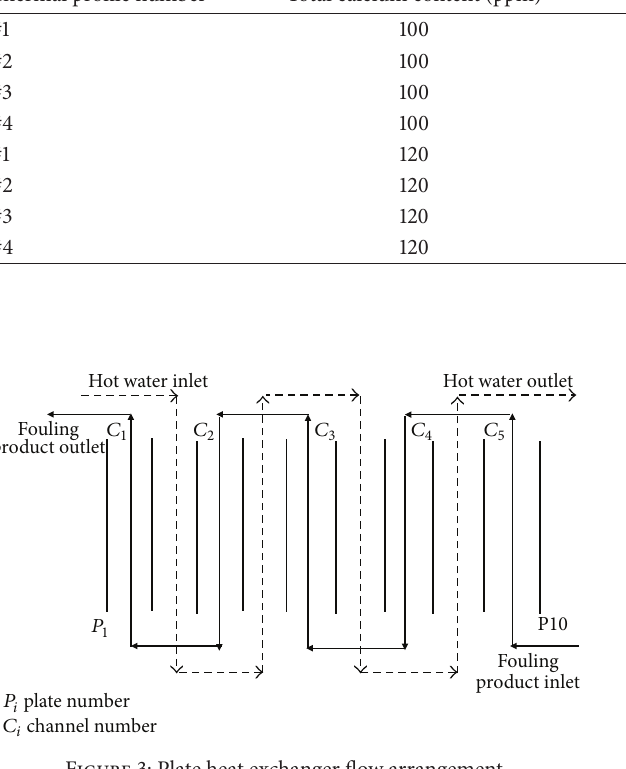
Figure 3: Plate heat exchanger flow arrangement.